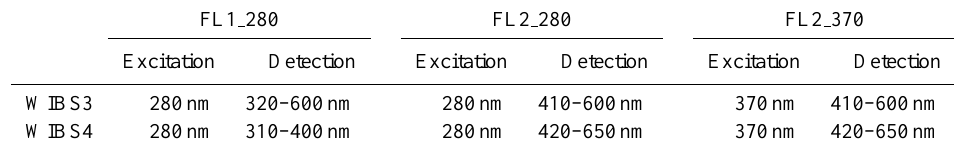
Table 1. The excitation and detection wavelengths of the two WIBS